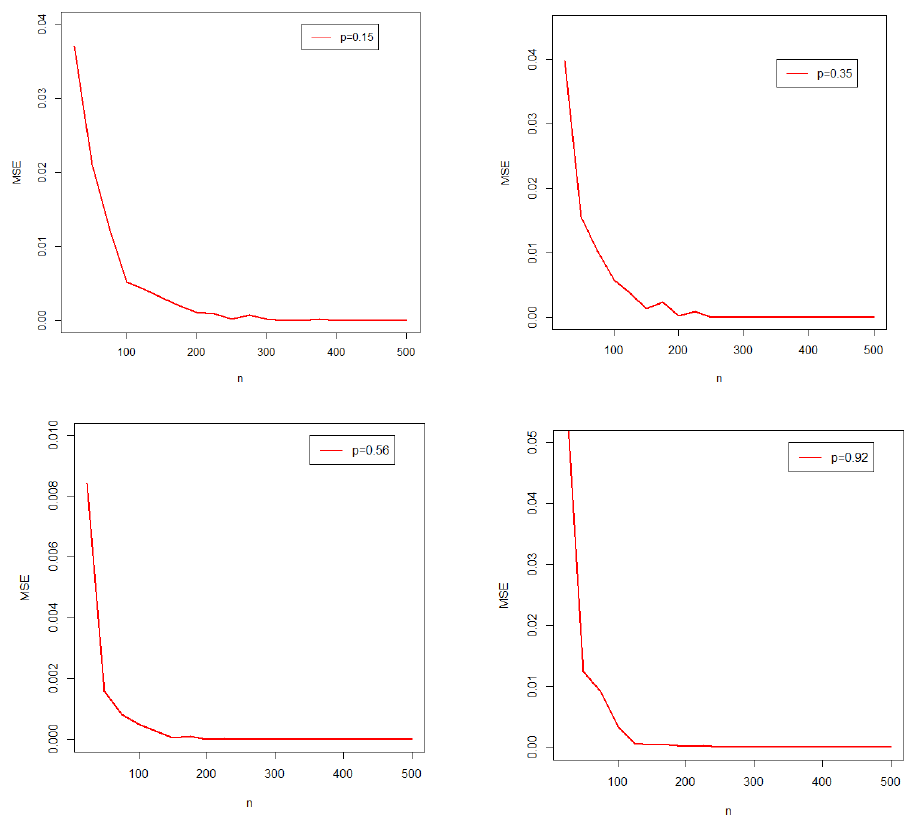
Figure 6. Plots of the estimated parameter and MSEs for various values of p .